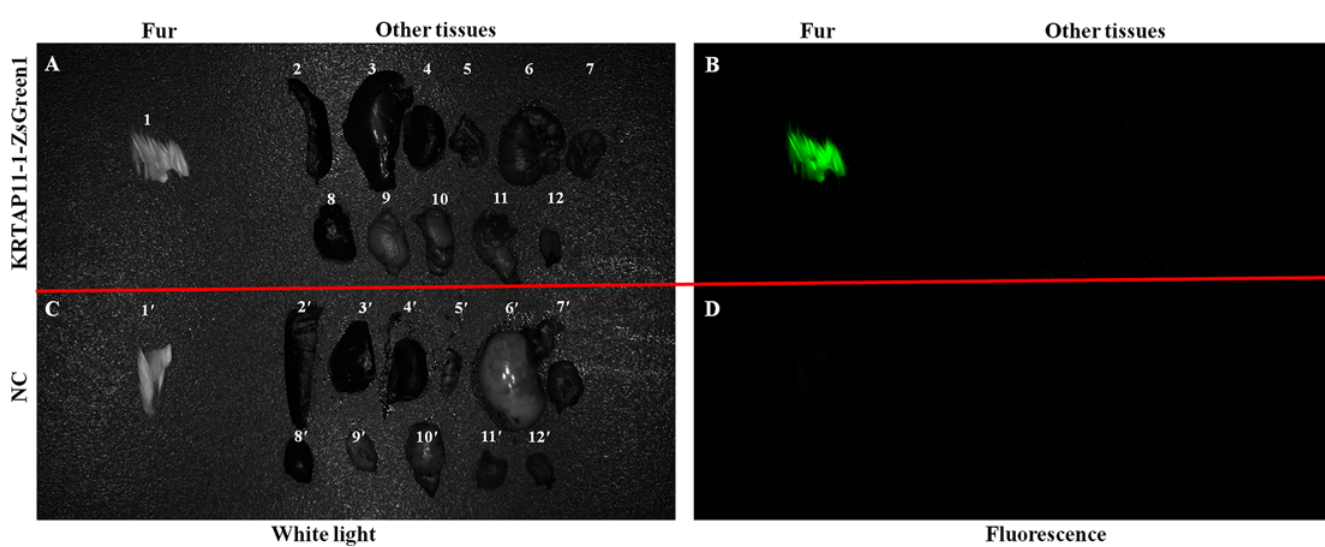
Fig 6. Fluorescence images of tissues from the KRTAP11-1-ZsGreen1 transgenic mouse. The tissues of KRTAP11-1-ZsGreen1 and negative mice were examined under white and fluorescent light. ( A) The tissues of the KRTAP11-1-ZsGreen1 transgenic mouse under white light. 1: Fur; 2: Spleen; 3: Liver; 4: Kidney; 5: Lung; 6: Stomach; 7: Intestines; 8: Heart; 9: Testis; 10: Brain; 11: Muscle; and 12: Tongue. (B) The tissues of the KRTAP11-1-ZsGreen1 transgenic mouse under fluorescent light. Only the fur showed a strong green fluorescent signal. (C) The tissues of the negative mouse under white light. 1 0 : Fur; 2 0 : Spleen; 3 0 : Liver; 4 0 : Kidney; 5 0 : Lung; 6 0 : Stomach; 7 0 : Intestines; 8 0 : Heart; 9 0 : Testis; 10 0 : Brain; 11 0 : Muscle; and 12 0 : Tongue. (D) The tissues of the negative mouse under fluorescent light.